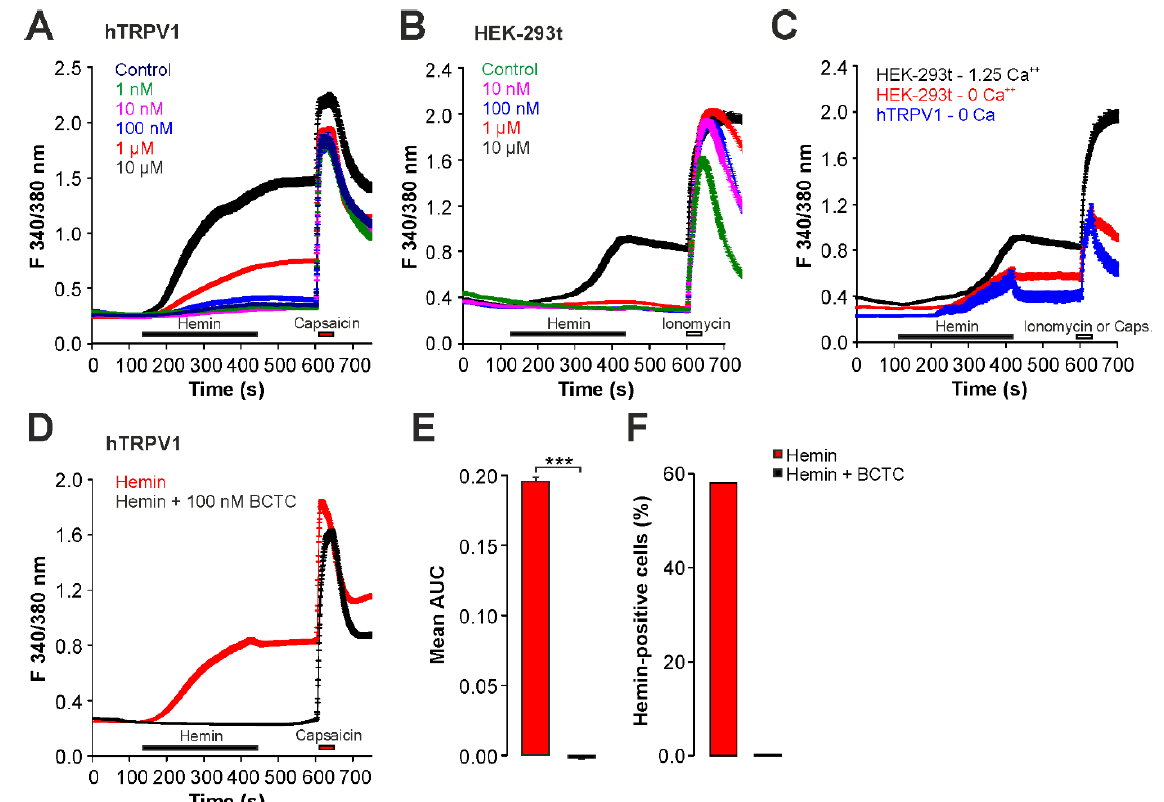
Figure 2. Hemin activates hTRPV1 when examined with calcium imaging. ( A , B ) Concentration-dependent activation of increase in intracellular calcium by hemin in HEK293t cells expressing hTRPV1 ( A ) or untransfected HEK293t cells ( B ). Hemin was applied for 300 s followed by washout and capsaicin (100 nM) or ionomycin (5 µM). Note that 1 µM hemin induces calcium responses only in cells expressing hTRPV1. ( C ) Hemin-induced (10 µM) calcium responses in naïve HEK-293t cells (red) or hTRPV1-expressing cells (blue) in nominal calcium-free extracellular solution. Following washout, capsaicin or ionomycin were applied in calcium-containing solution. For comparison, the calcium response of HEK293t cells to 10 µM hemin in calcium-containing solution is also displayed (black). ( D ) Hemin-induced (1 µM) calcium responses in hTRPV1-expressing cells with or without (application of) the TRPV1-inhibitor BCTC (100 nM). Following washout, capsaicin (100 nM) was applied to verify expression of hTRPV1. ( E ) Area under the curve (AUC) for hemin-induced increase in fluorescence ratio described in ( D ). ANOVA F(5, 3787) = 196.42, p < 0.001. ( F ) Fraction of hTRPV1-expressing cells displaying an increased intracellular calcium following hemin or hemin in combination with BCTC. *** denotes p< 0.001.